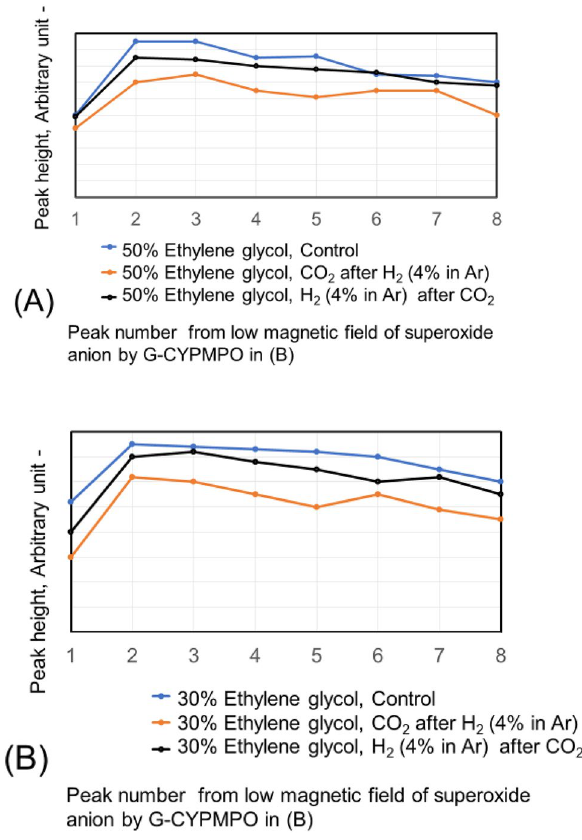
Figure 12. Peaks of superoxide anion radical with ESR by blowing CO 2 after H 2 (4% in Ar) gas nanobubble and H 2 (4% in Ar) after CO 2 gas nanobubble into 50 and 30% ethylene glycol aqueous